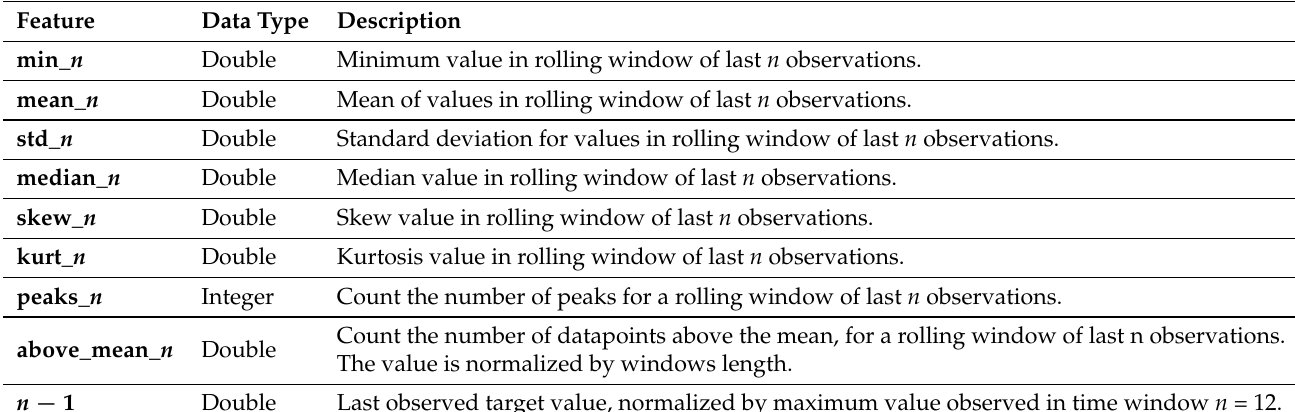
Table 2. Description of features we created for each dataset. We used n = 3, 5, 7,